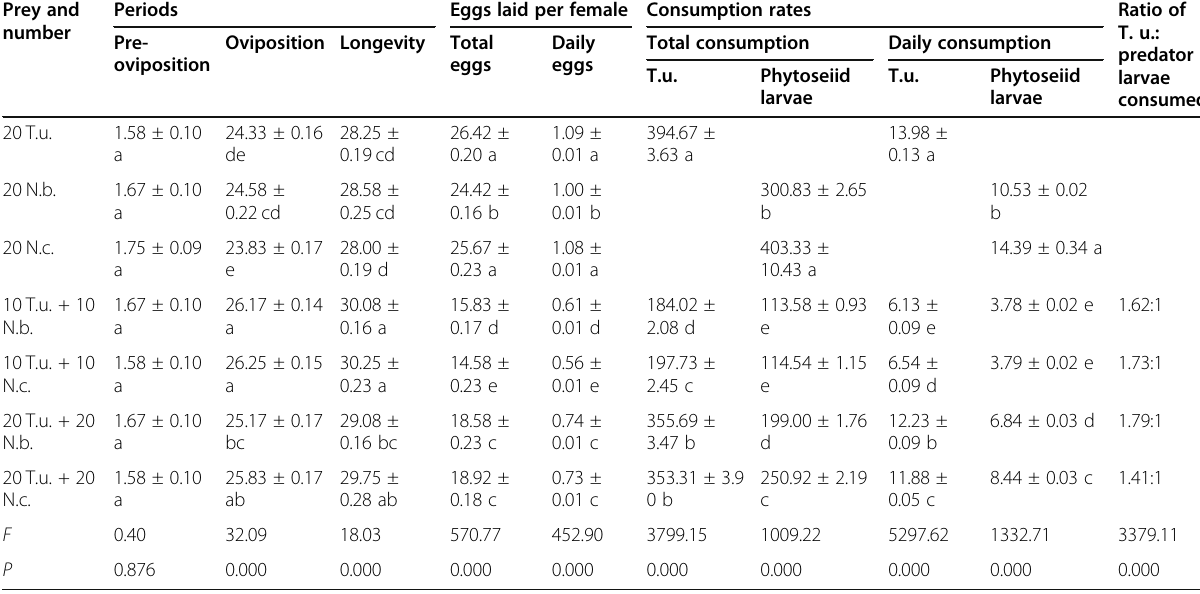
Table 3 Mean (± SE) pre-oviposition, oviposition periods and longevity, mean number (± SE) of total and daily eggs laid per female, total and daily number (± SE) of prey consumed per female for Amblyseius swirskii fed solely on Tetranychus urticae (T.u.) or larval Neoseiulus barkeri (N.b.), Neoseiulus californicus (N.c.), or on a combination of T. urticae and larval